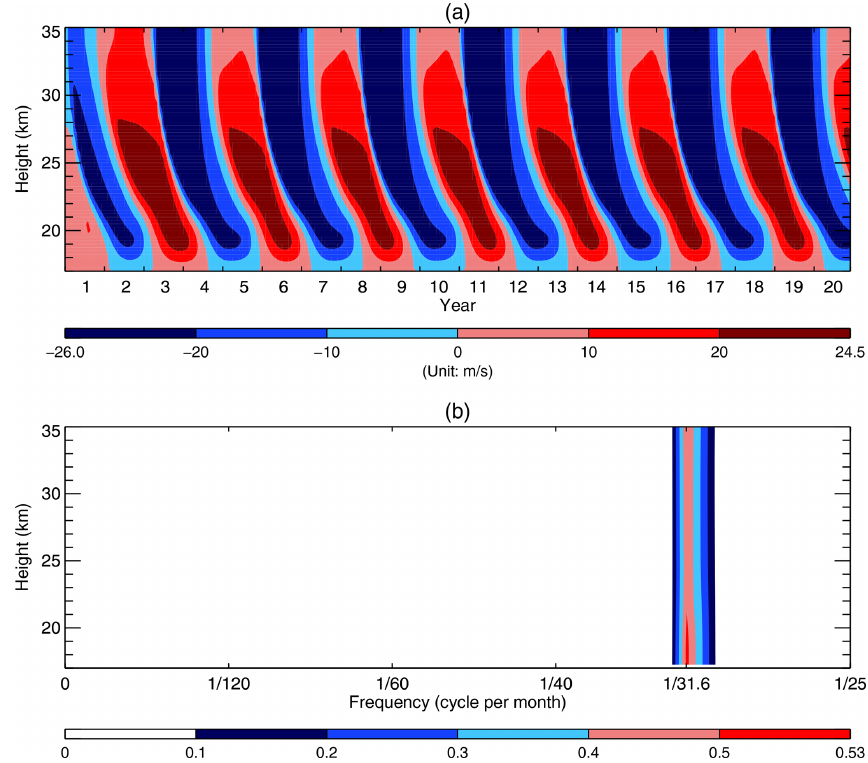
Figure 5. (a) Same as Fig. 4a but with the enhanced α(z) depicted as the red line in Fig. 1a. (b) Same as Fig. 4b but for the doubled CO 2 run.